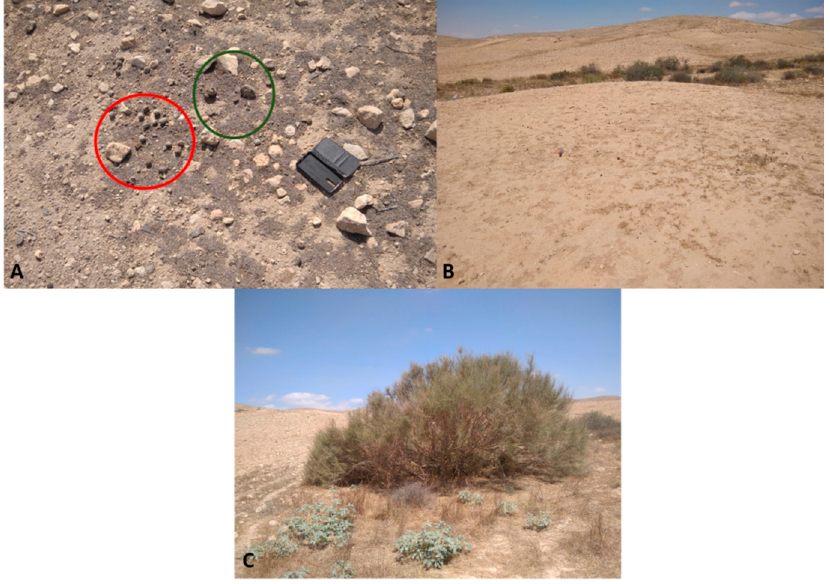
Figure 4. Dropping types and concluded animal distribution from the WOS (2/2021). ( A ) Camels and small ruminant droppings; ( B ) homogenous distribution; ( C ) Retama raetam with high droppings in its surrounding.